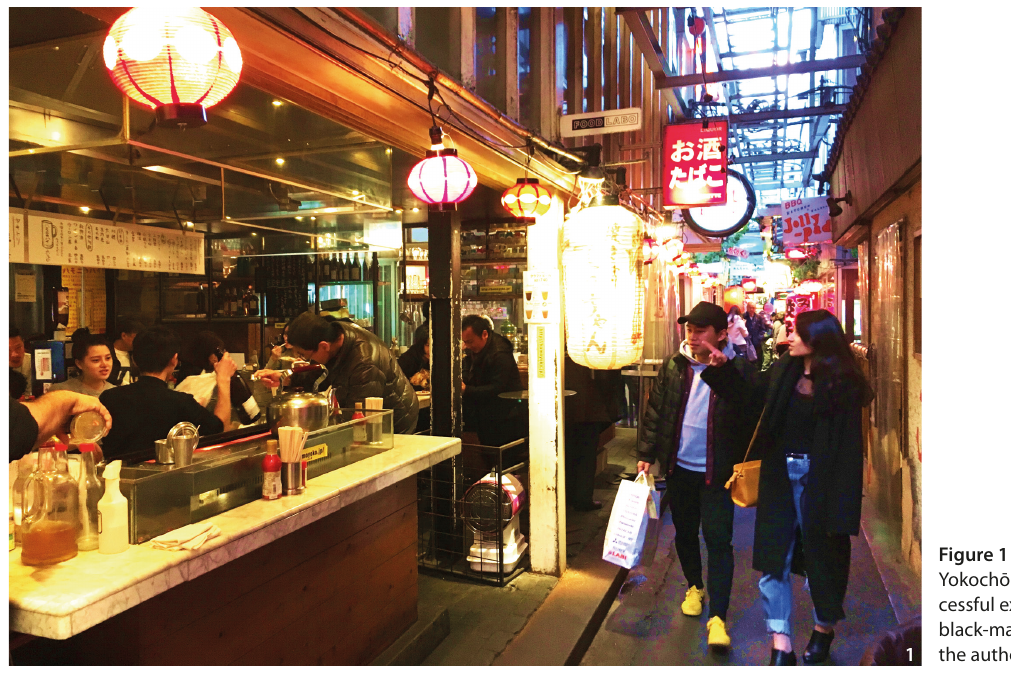
Figure 1 Kichijoji’s Harmonica Yokochō is one of the most suc- cessful examples of a revived black-market bar street. (Source: the author).